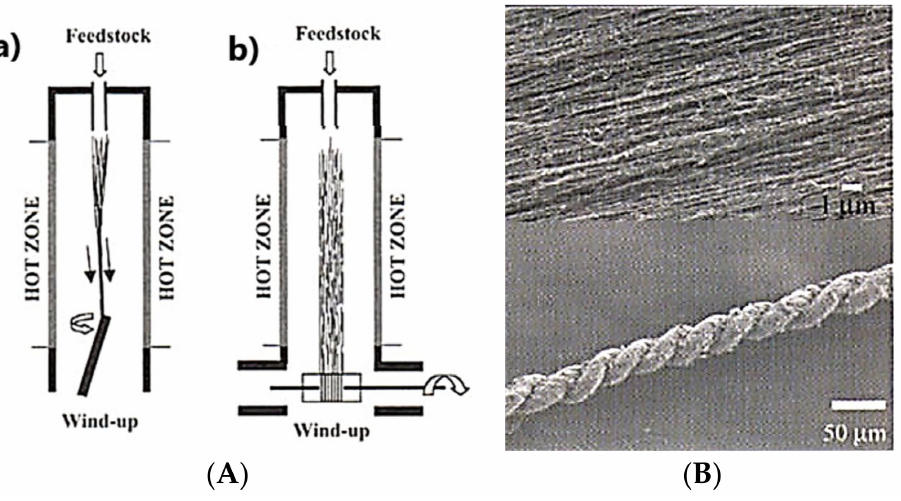
Figure 6. ( A ) ( a ) Schematic of the direct spinning process, called the floating catalyst CVD process. Liquid feedstocks such as ferrocene and thiophene are dissolved in ethanol, mixed with H 2 , and then injected into a hot zone where the CNT aerogel is formed. This aerogel is captured and wound out of the hot zone by an offset rotating spindle. ( b ) Schematic of the wind-up assembly operating at a lower temperature, outside the furnace hot zone.( B ) SEM images of well-aligned multiwall carbon nanotubes (MWCNTs) along with a twisted fiber collected from the furnace. Reprinted with permission from